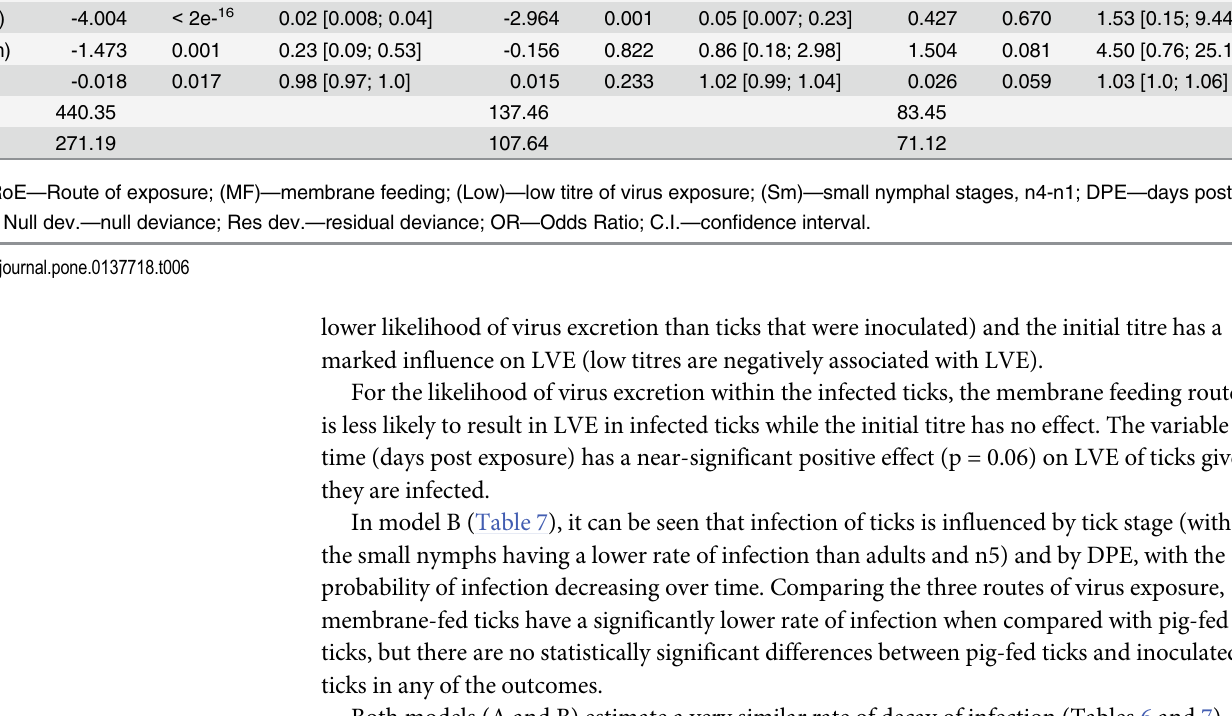
Table 6. Logistic regression model A — Effect of route of exposure (Inoculation versus Membrane feeding) and titre of exposure (high versus low titres), controlling for tick stage and days post exposure, in infection (n = 440), likelihood of virus excretion (LVE) (n = 440) and likelihood of virus excretion within the infected ticks (LVE within the infected ticks) (n = 88).